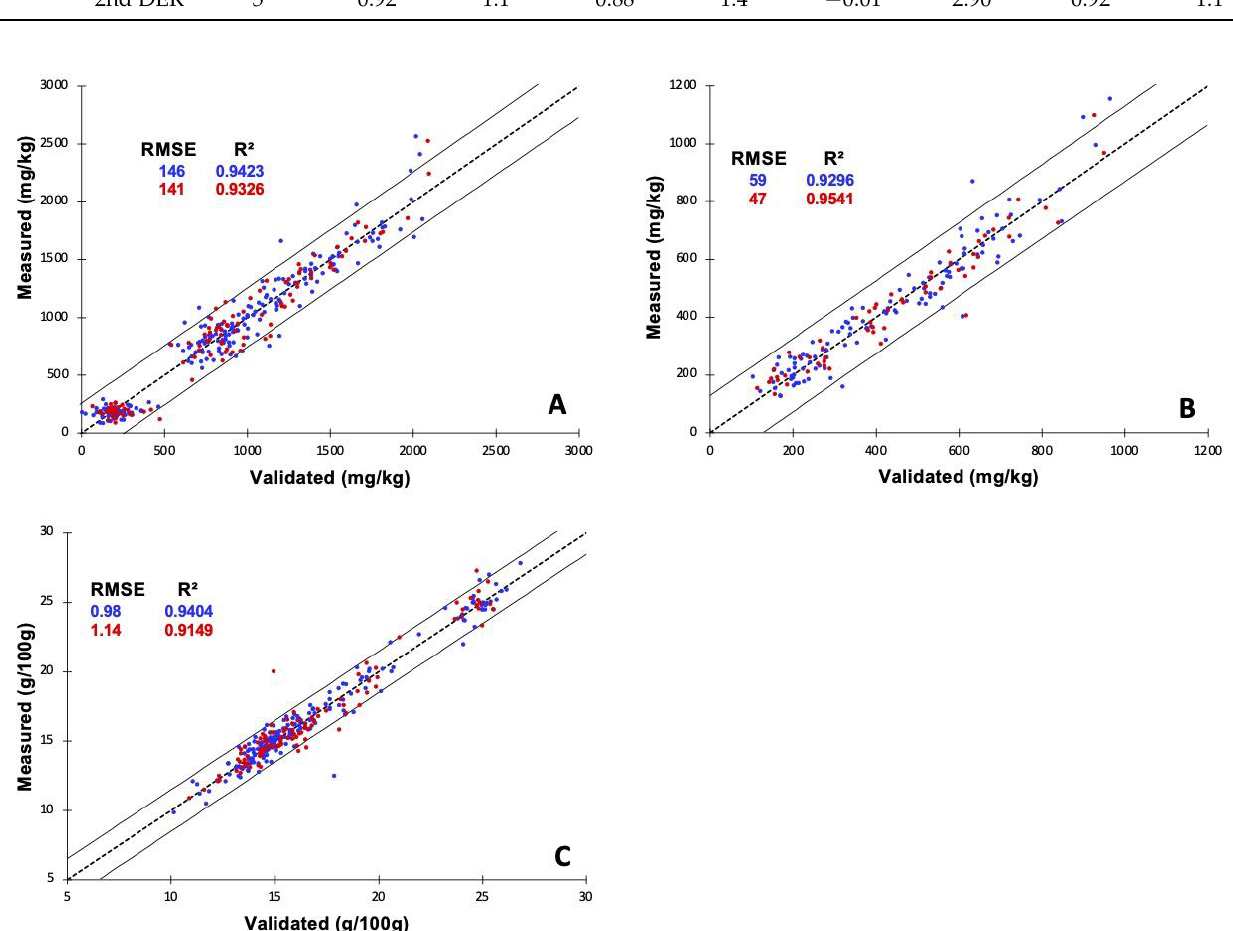
Figure 3. Performance of partial least square (PLS) model using the spectral data pre-treated by SNV. Calibration and external validation for total flavonoids using 9 factors ( A ), for Total Anthocyanins using 3 factors ( B ), and for Total Soluble Solids using 10 factors ( C ). Blue dots indicate calibration set and red dots represent validation set. R 2 : determination coefficient, RMSE: root mean squared error.